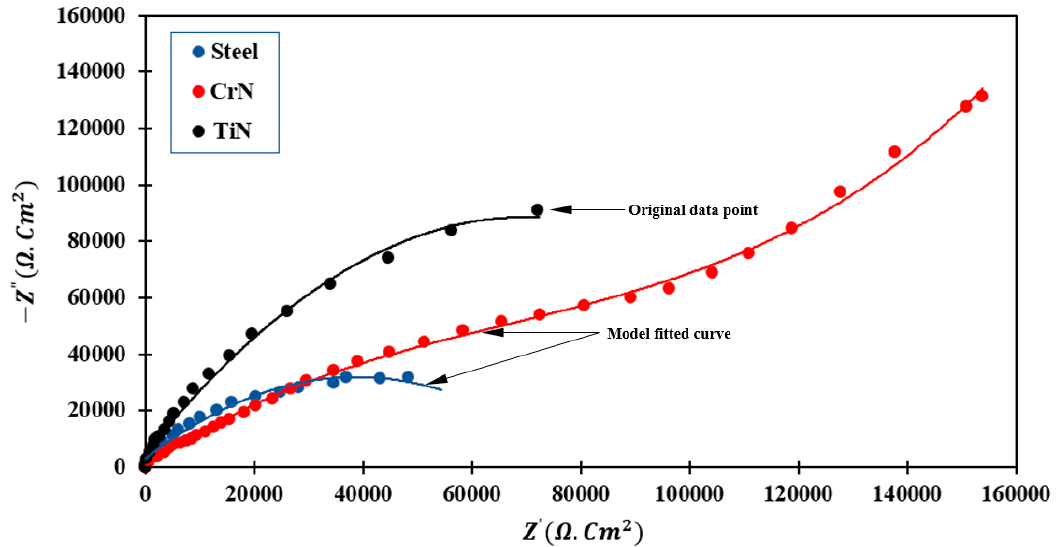
Figure 9. EIS Nyquist plot of different specimens in Ringer’s solution.